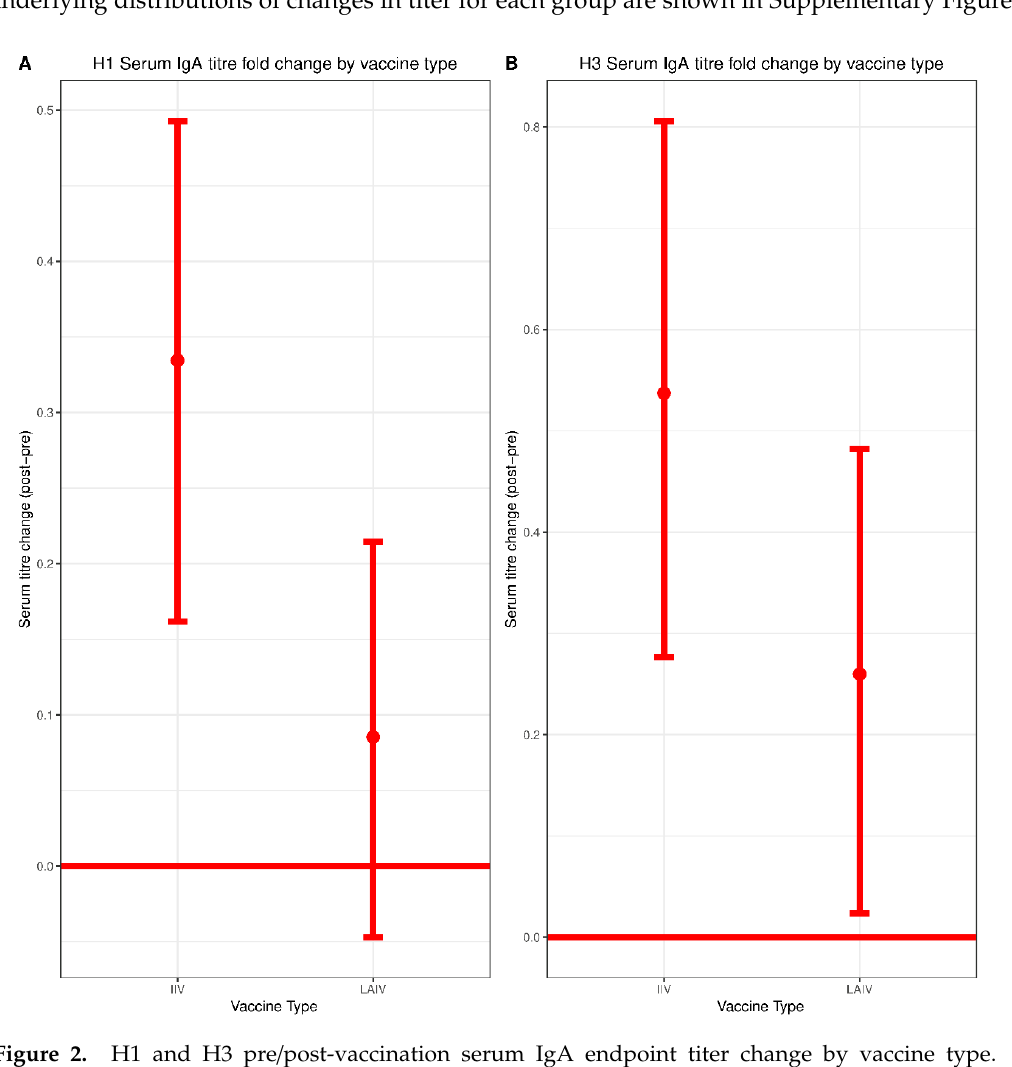
Figure 2. H1 and H3 pre/post-vaccination serum IgA endpoint titer change by vaccine type. Endpoint enzyme-linked immunosorbent assays (ELISA) assays were performed to measure titers of serum-derived IgA using ( A ) recombinant Cal/09 H1 protein or ( B ) recombinant Tex/50 H3 protein. Log 2 transformed changes in endpoint IgA titer from pre-vaccination to post-vaccination were plotted for each vaccine formulation. LAIV, n = 340; IIV, n = 278. Significance of IgA endpoint titer change within each vaccine group was evaluated by paired Student t test. Di ff erences between vaccine groups (IIV vs. LAIV) were assessed using Mann–Whitney U